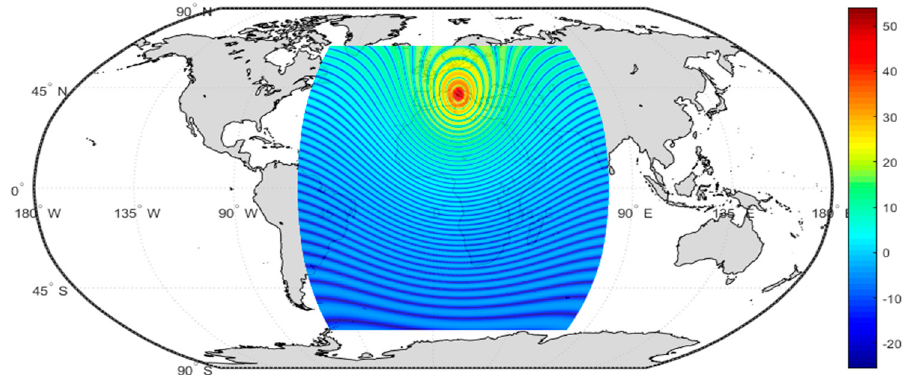
Figure 2. Directivity (in dB) for a 5 m diameter, X band antenna, paced on a GEO-SAR satellite and pointing at Central Italy.